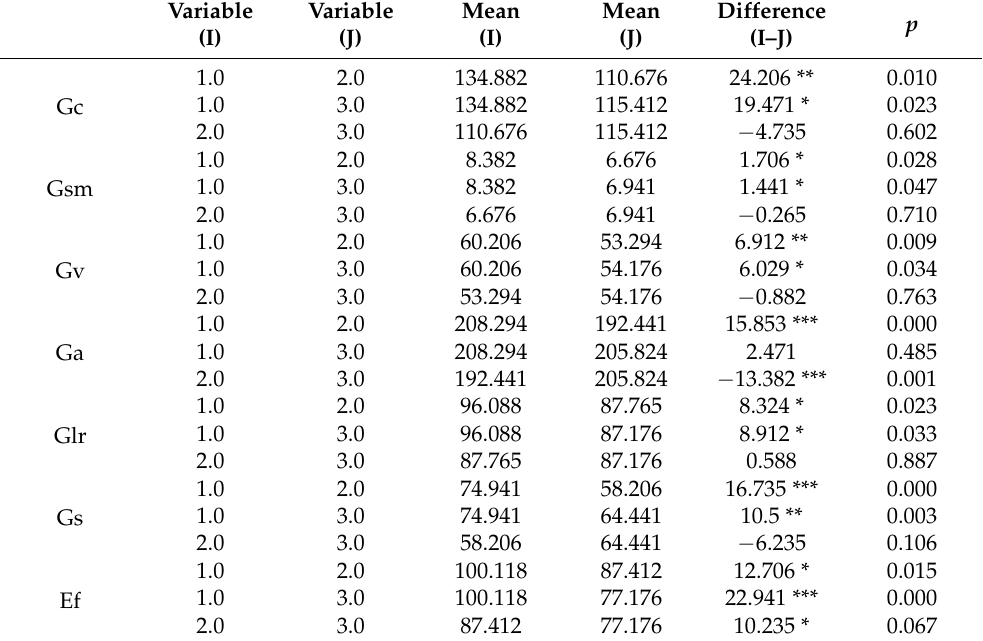
Table 6. The results of multiple comparisons after ANOVA among the study groups in grades 1 to